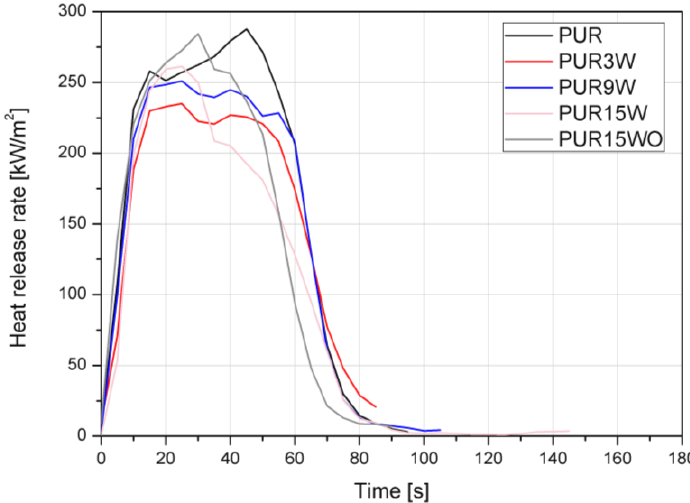
( b ) Figure 10. TG ( a ) and DTG ( b ) curves of polyurethane samples with various contents of vermicu-